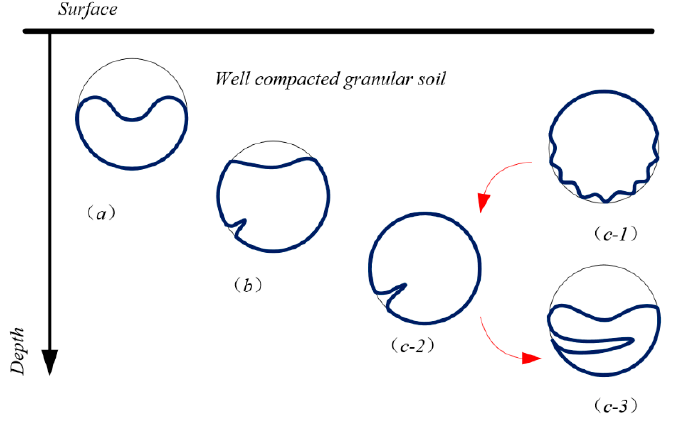
Figure 12. Collapse modes of thin-walled buried cylinders. ( a ) Shallow cover, ( b ) intermediate cover and ( c ) deep cover; and ( c-1 ) lower rim buckles and ( c-2 ) one buckle grows ( c-3 ) final shape.